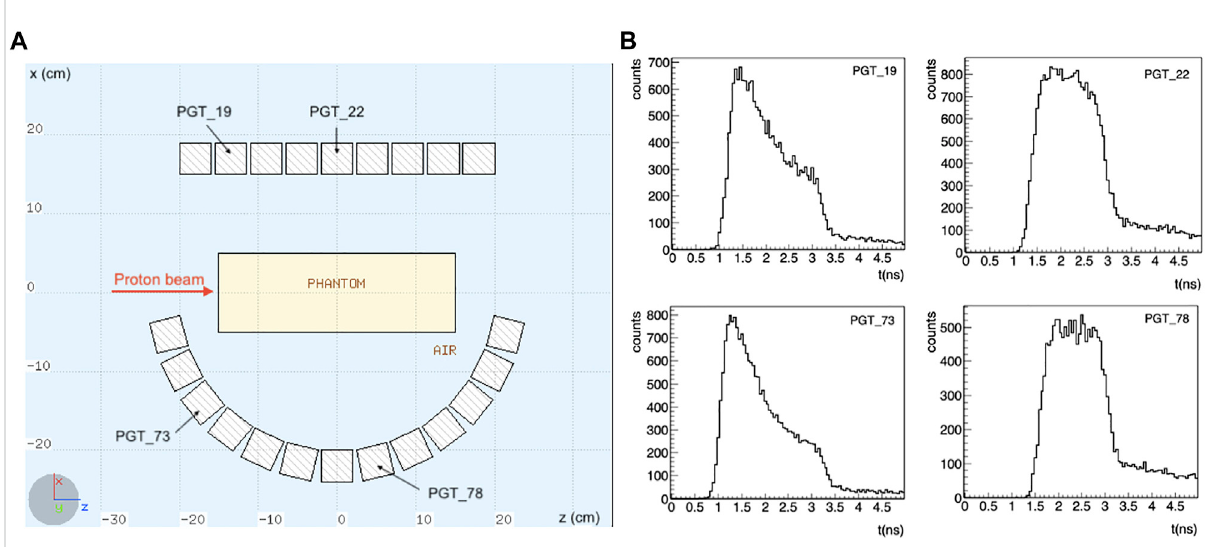
FIGURE 1 (A) Schematics ofthesimulated setup. A totalof110LaBr 3 :Cedetectorsisconsidered, placedasymmetrically aroundthetarget, in5rowsalong the y axis. Only the central section of the setup is shown. The proton beam is impinging towards the positive z direction in a homogeneous PMMA phantom. (B) SomeexemplaryTOFdistributionsfora200 MeVprotonbeamareshown.TheTOFshapechangesdependingonthedetectorposition with respect to the target. A timing resolution of 250 ps FWHM was